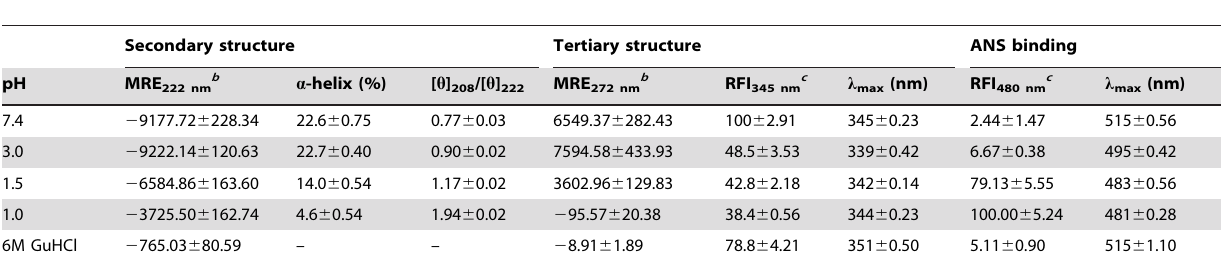
Table 1. Spectroscopic properties of chymopapain at different pH and under denatured condition. a